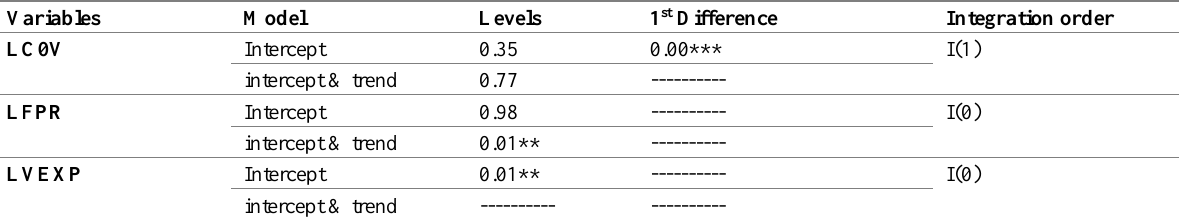
Table 4: Results of Unit Root